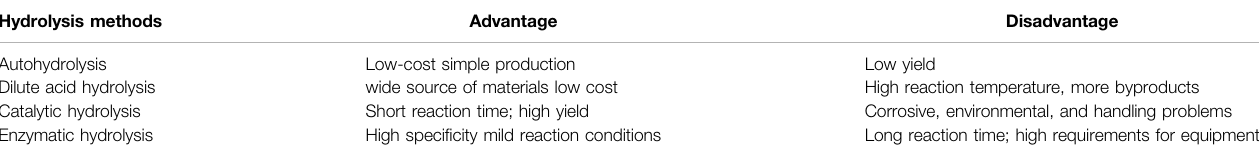
TABLE 1 | The comparison of four hydrolysis